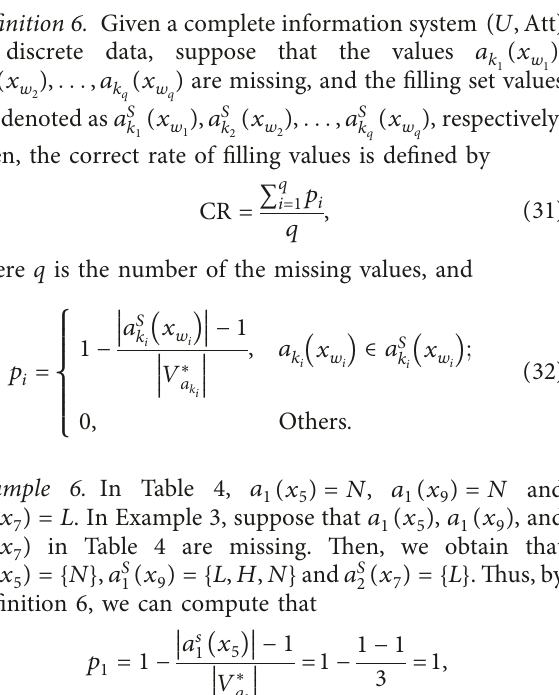
rates of filling values.